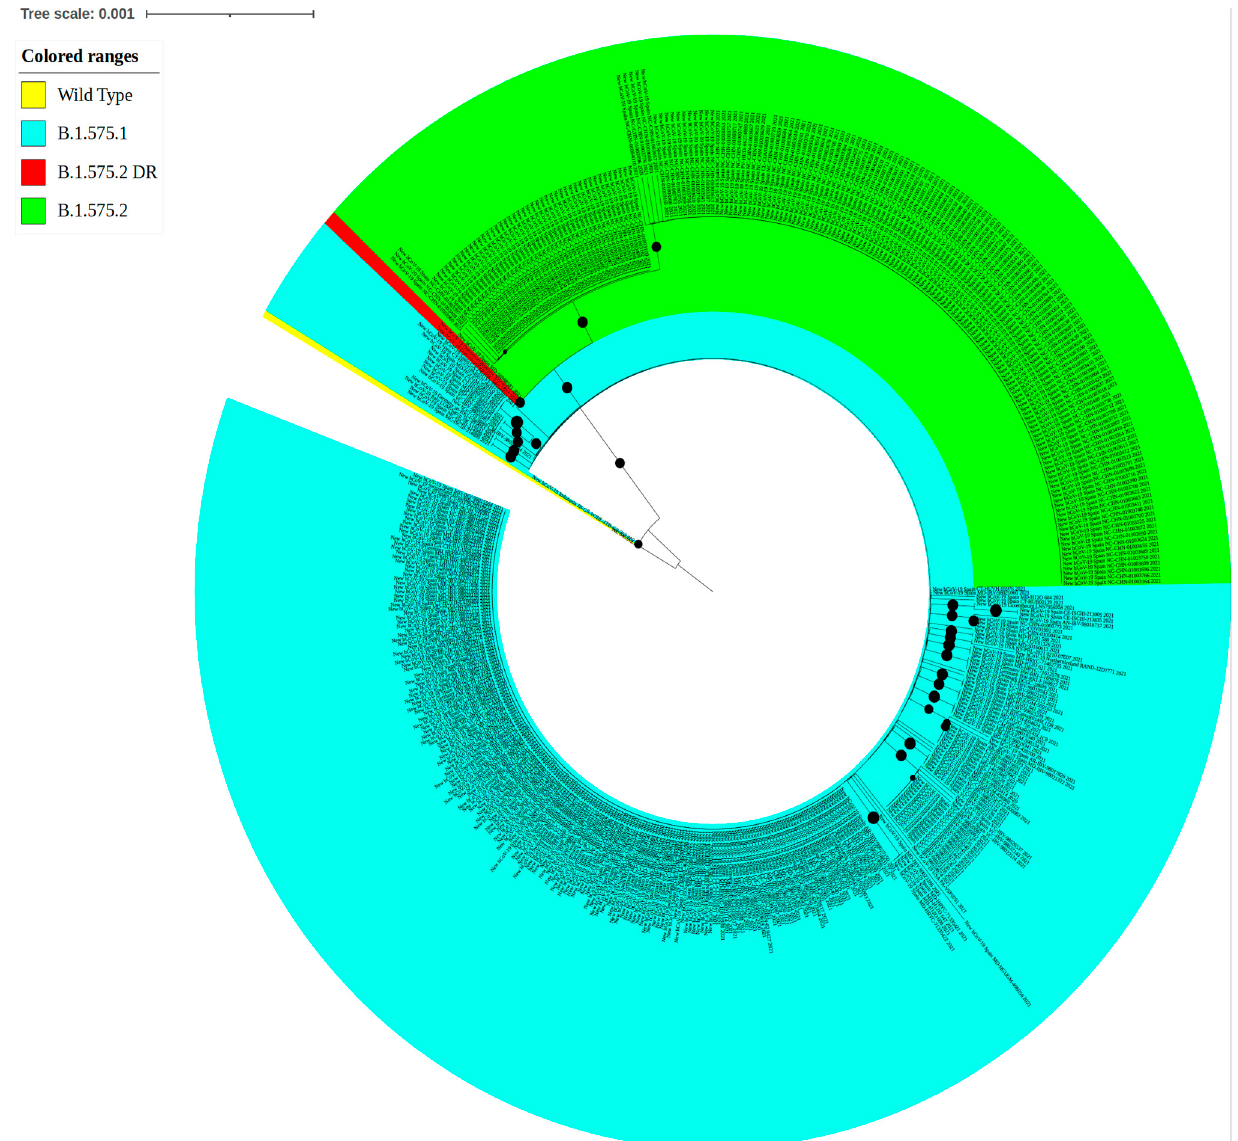
Figure 5. Maximum likelihood phylogenetic analysis of the B.1.575 lineage. The phylogenetic evaluation of the B.1.575 lineage was inferred using the maximum likelihood method implemented in the IQ TREE web server. The bootstrap consensus tree was inferred from 1000 replicates. The colors indicate the SARS-CoV-2 spike variant, and the bullets (•) indicate branches with a bootstrap value of >0.70. The visualization was created using the online software tool iTOL v.5 (B).